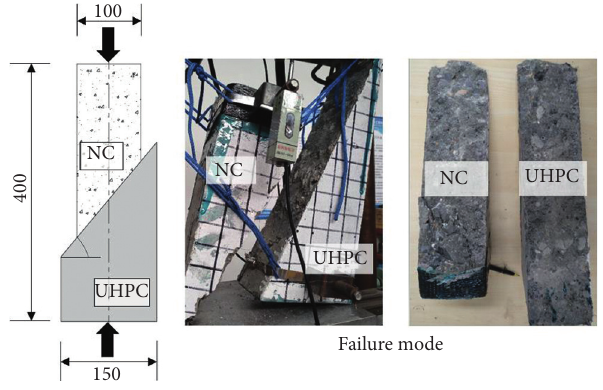
Figure 7: Geometry of interface specimens (mm). Table 4: Slant shear strength results.